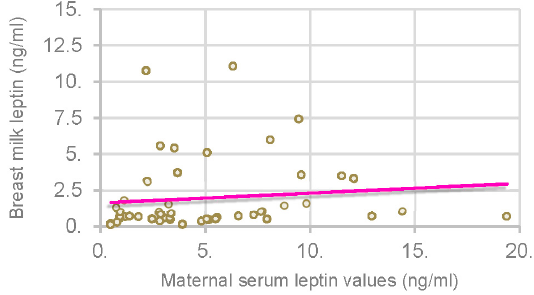
Figure 3. Correlation between maternal serum leptin and breast milk leptin.